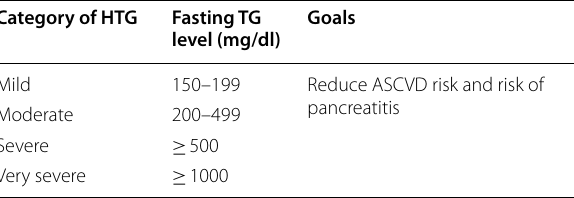
Table 1 Categories of hypertriglyceridemia and goals of